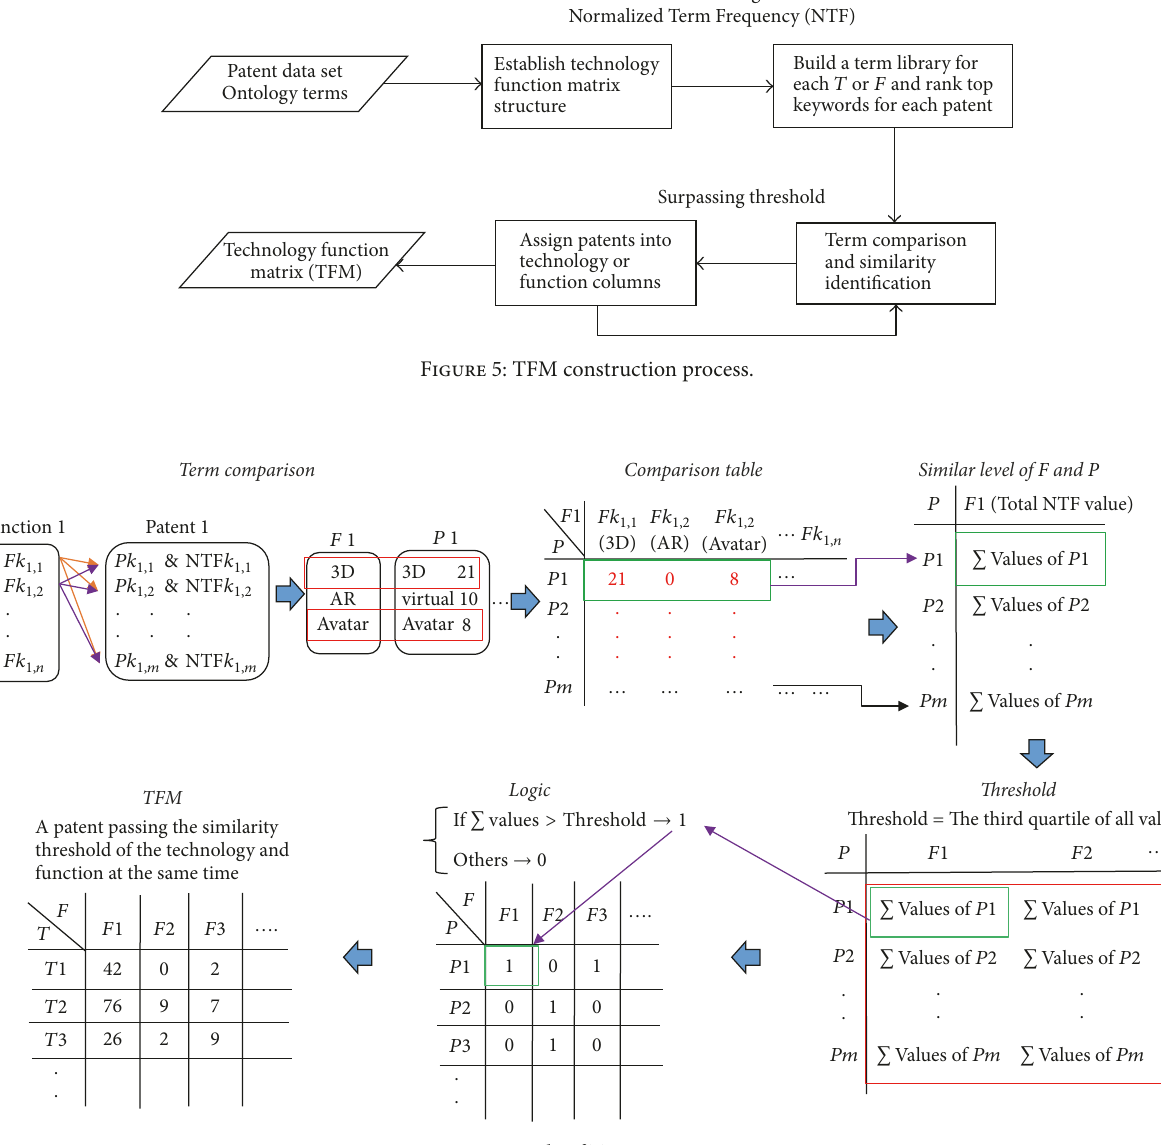
Figure 6: An example of TFM generation